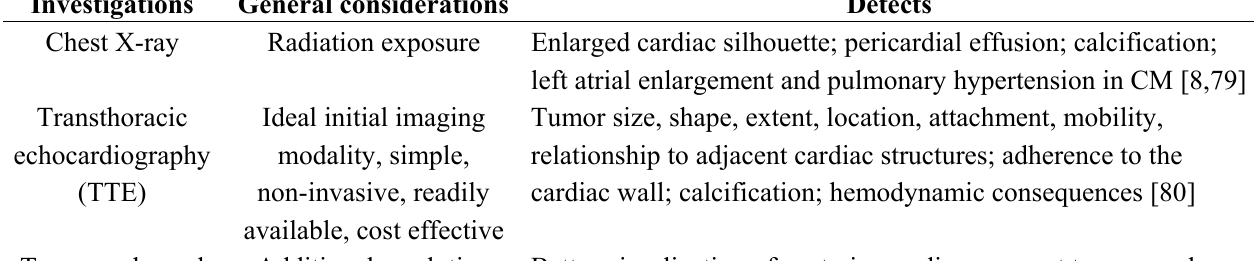
Table 2. Investigations in primary cardiac